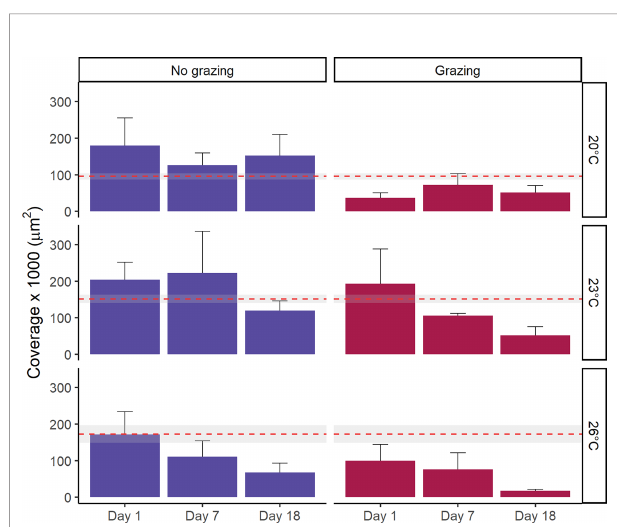
FIGURE 2 | Mean total coverage of Ecklonia radiata gametophytes (µm 2 ) at three temperatures (20 °C, 23°C and 26°C) tracked over an 18-day period after exposure to grazing. Error bars represent SE ( n = 5). The red dashed line represents the mean coverage of each temperature treatment prior to grazer exposure (i.e. baseline coverage data), with the grey area denoting the 95% con fi dence interval.